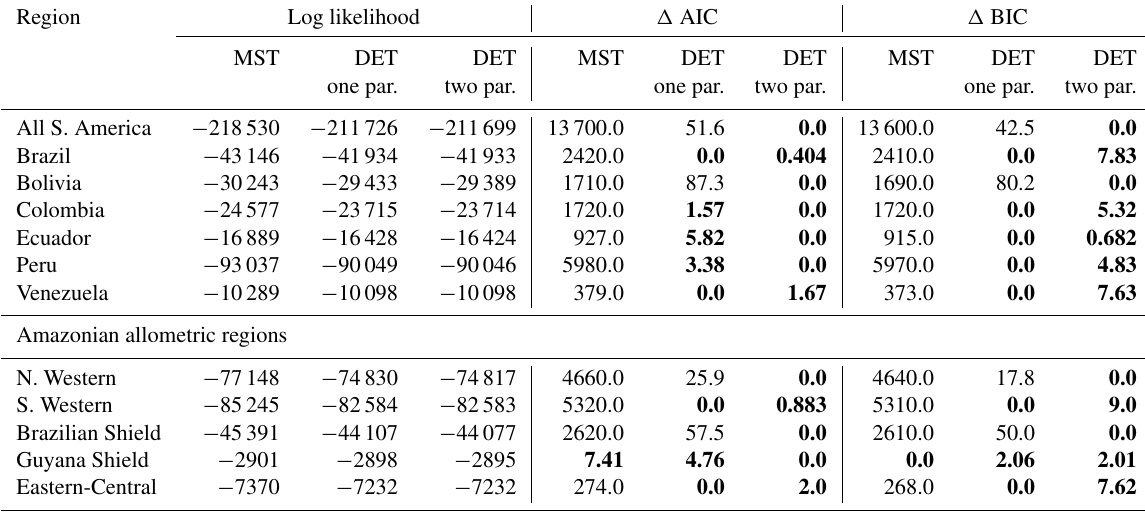
Table 2. Model comparison for fits to trunk diameter size distributions. This table shows the log likelihood of each model’s fit and the corresponding AIC and BIC model comparison criterion. The best model has the lowest AIC or BIC; here the difference is shown compared to the best model, meaning the best model has a score of 0. Models other than the best are strongly rejected if they have a value greater than 10. The best model and those not rejected are shown in bold.